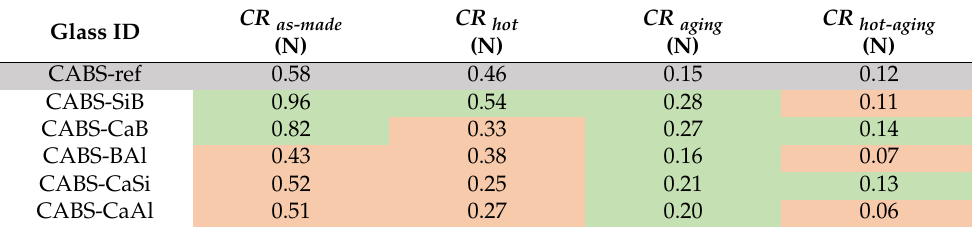
Table 6. Crack resistance (CR) for cube corner indentation of the as-made, hot-compressed, humid- aged, and hot-compressed/humid-aged CABS glasses. Coloring indicates CR value of reference glass (grey), and decreasing CR relative to reference (red).